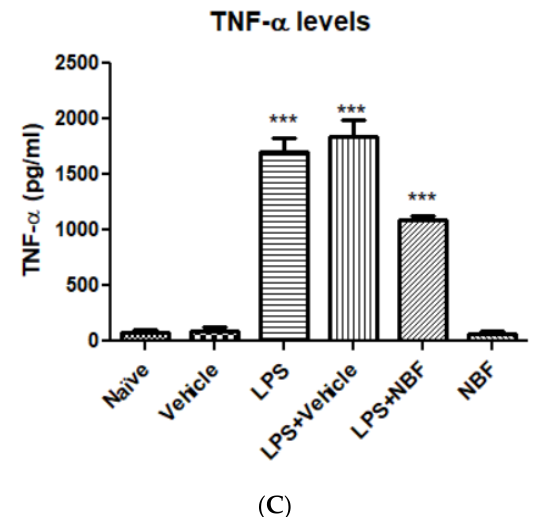
Figure 2. NBF downregulates the release of pro-inflammatory cytokines induced by LPS in RAW264.7 macrophages. RAW 264.7 macrophages were exposed to 20 ng/mL LPS and simultaneously with the NBF, 20 µg/mL. IL-1 β ( A ), IL-6 ( B ), and TNF- α ( C ) levels were measured using ELISA. The results are presented as the mean ± SD, ( n = 4 in each group). ANOVA followed by Bonferroni’s post hoc test was performed. *** p < 0.001 compared to all other groups.